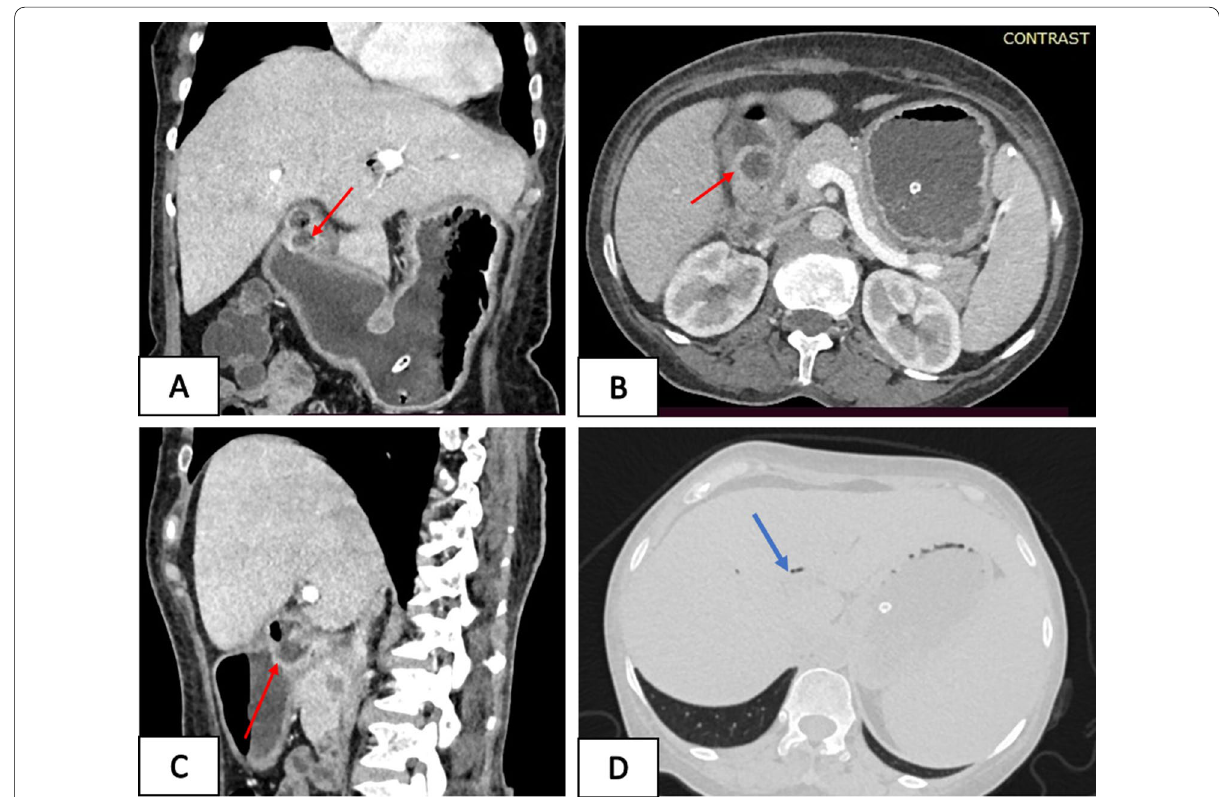
Fig. 1 A – C Contrast-enhanced computed tomography images in coronal ( A ), axial ( B ) and sagittal ( C ) sections showing submucosal impaction of gallstone (hypodense) with surrounding mucosal thickening (red arrow) at pylorus causing gastric outlet obstruction. D Axial CT images in lung window to show pneumobilia (blue